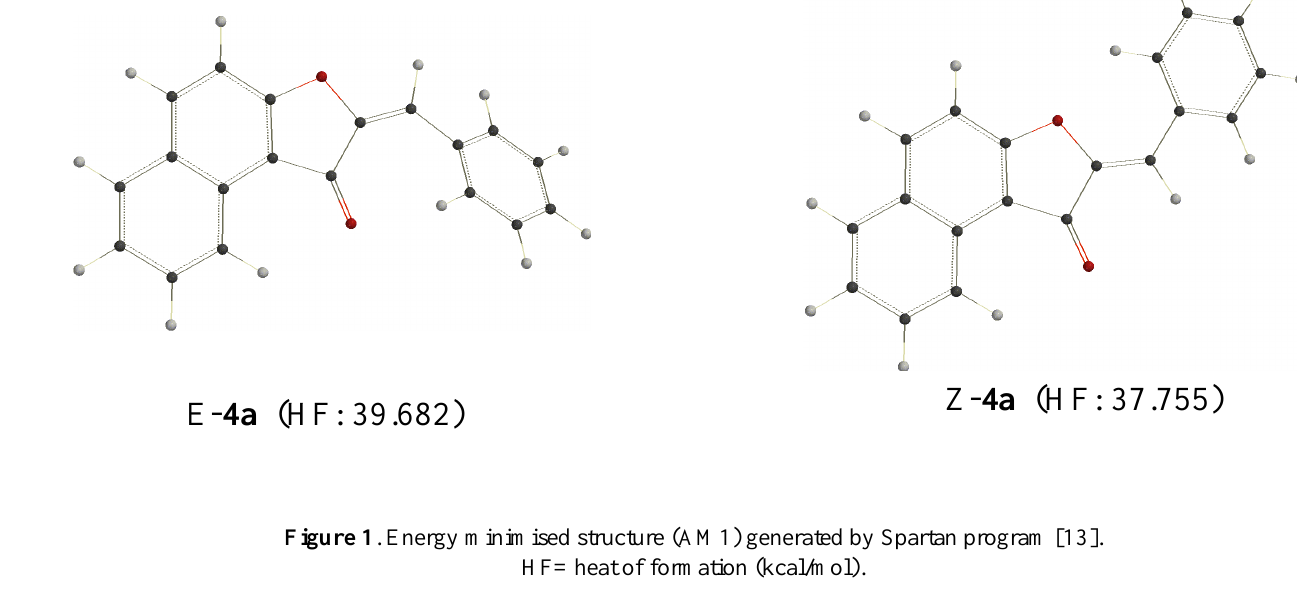
Figure 1 . Energy minimised structure (AM1) generated by Spartan program [13]. HF= heat of formation